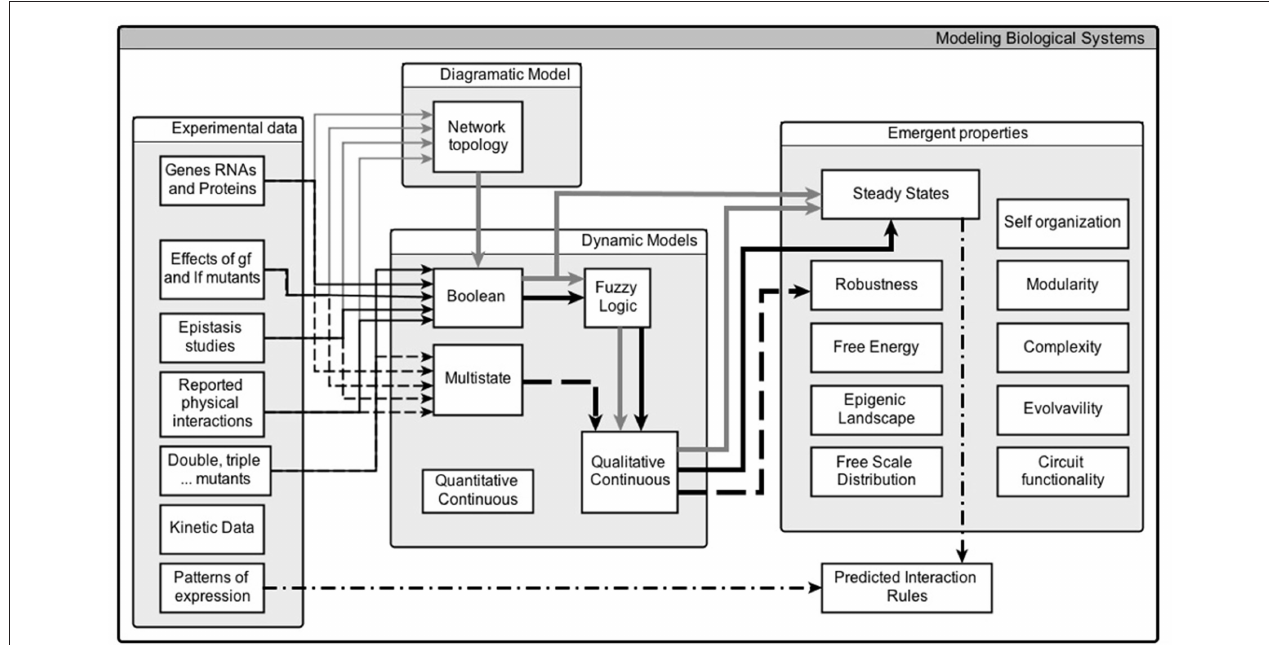
Figure 1 | The use of SQuAD in the analysis of regulatory networks (see main text for